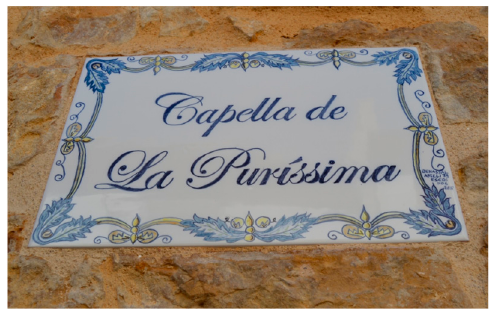
Figure 3. Benasal: Valencian-only sign on a chapel.